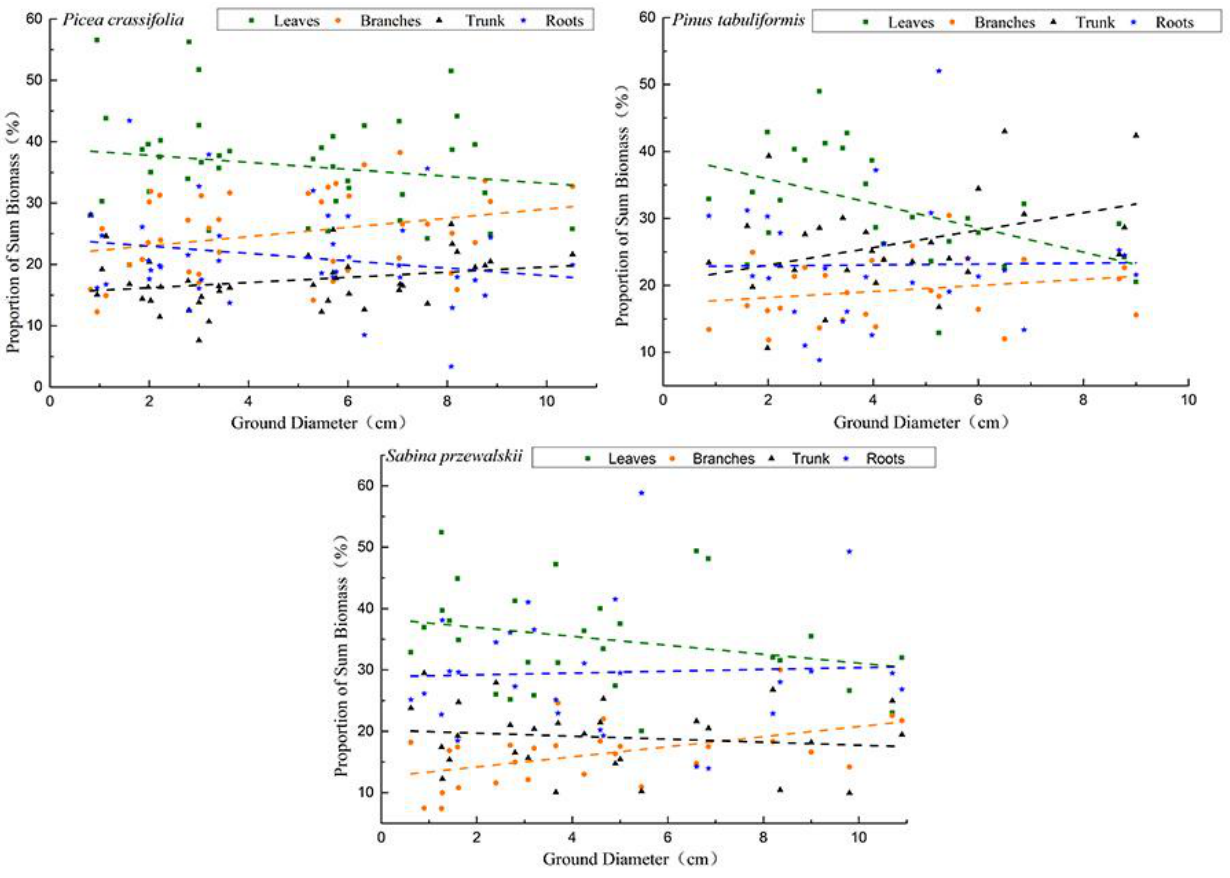
Figure 2. Changes in the proportion of biomass of each component relative to the total biomass of the three tree species.